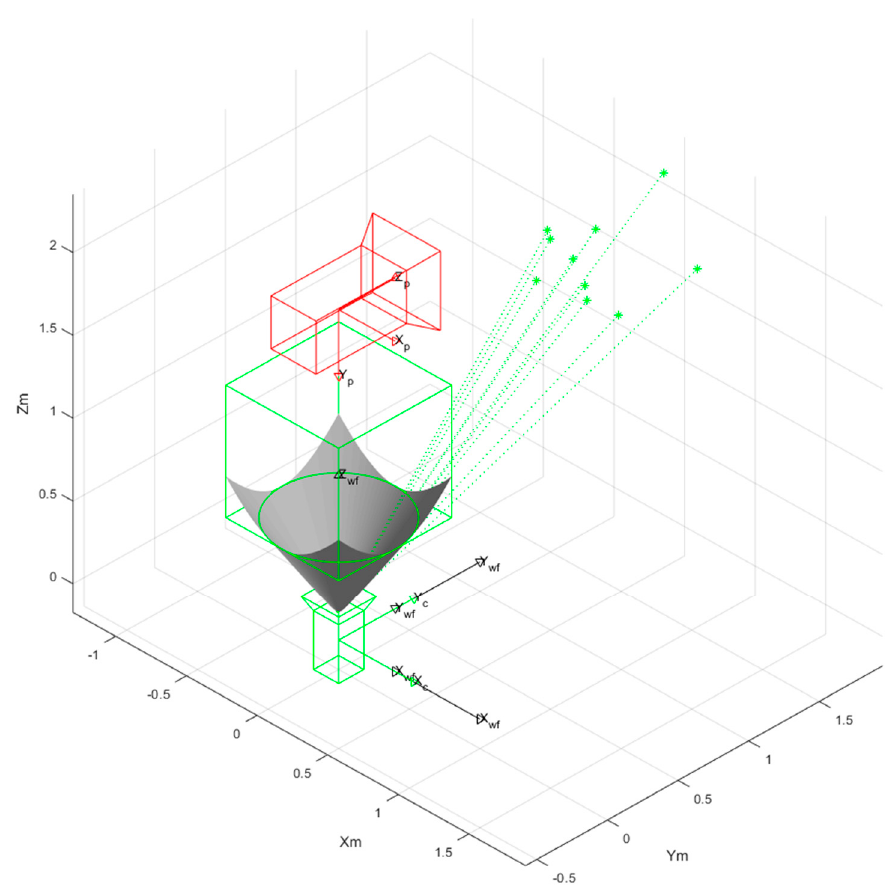
Figure 10. A simulated environment with one omnidirectional image and one conventional image.